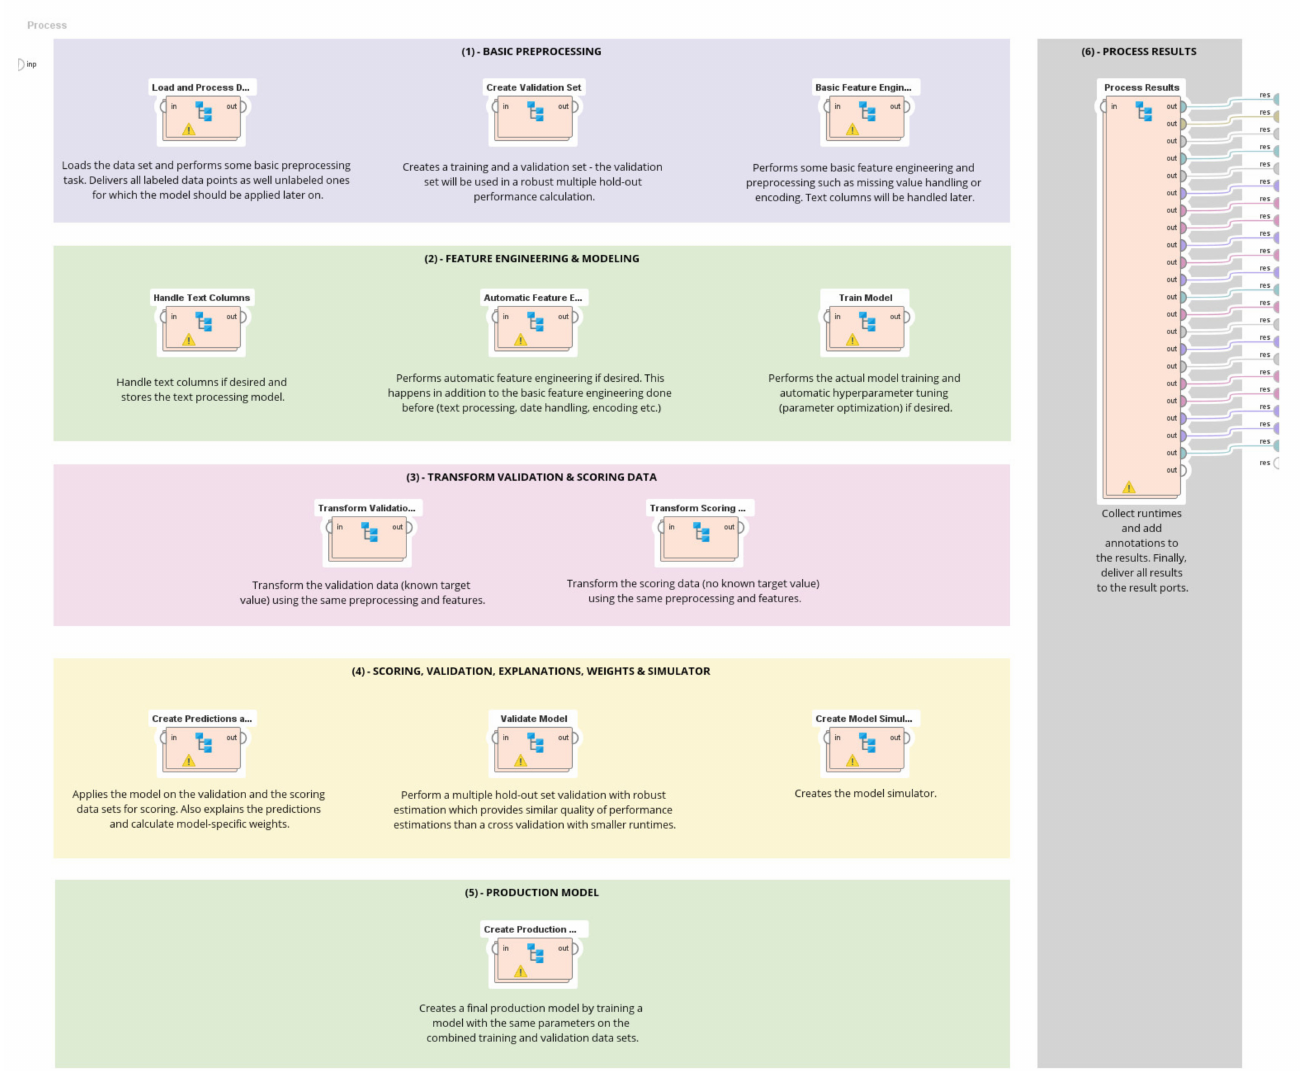
Figure A1. The process of creating a Decision Tree from RapidMiner ®